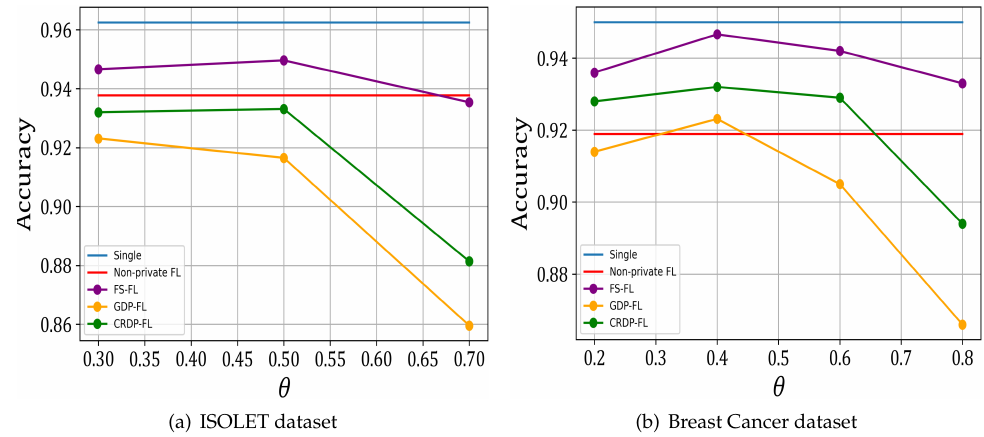
Figure 3. The accuracy of the algorithms varies with the feature selection thresholds on differ- ent